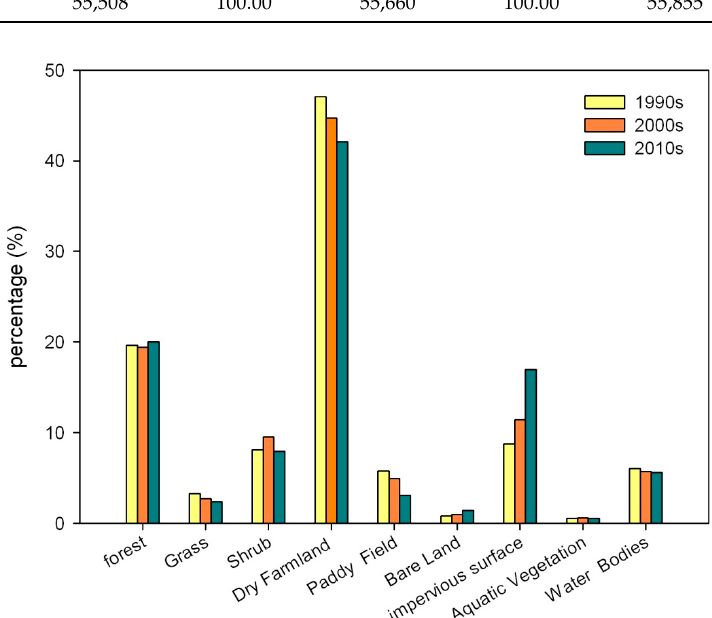
Figure 8. Percentages of different land cover areas for the three periods. Table 4. Error-adjusted areas and proportions of the classes for the three periods.